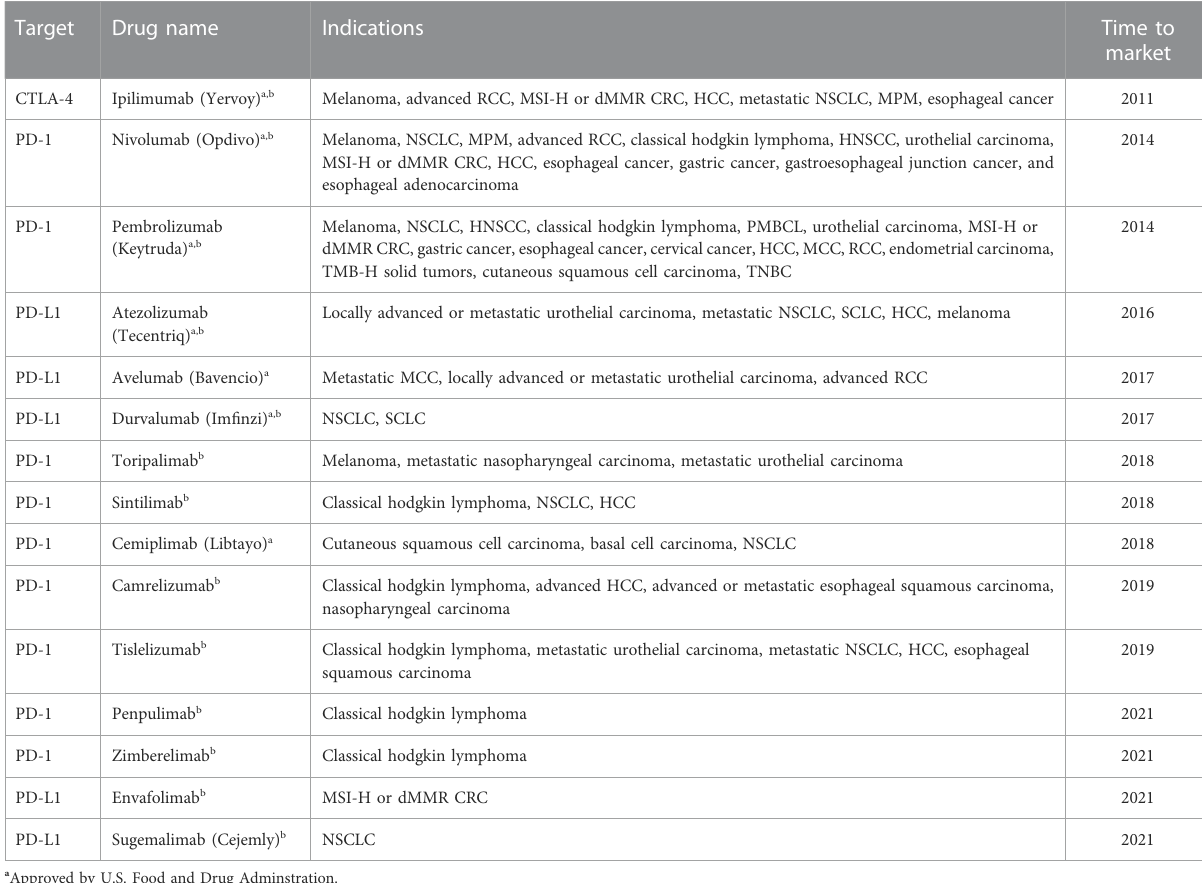
TABLE 1 Immune checkpoint inhibitors and their